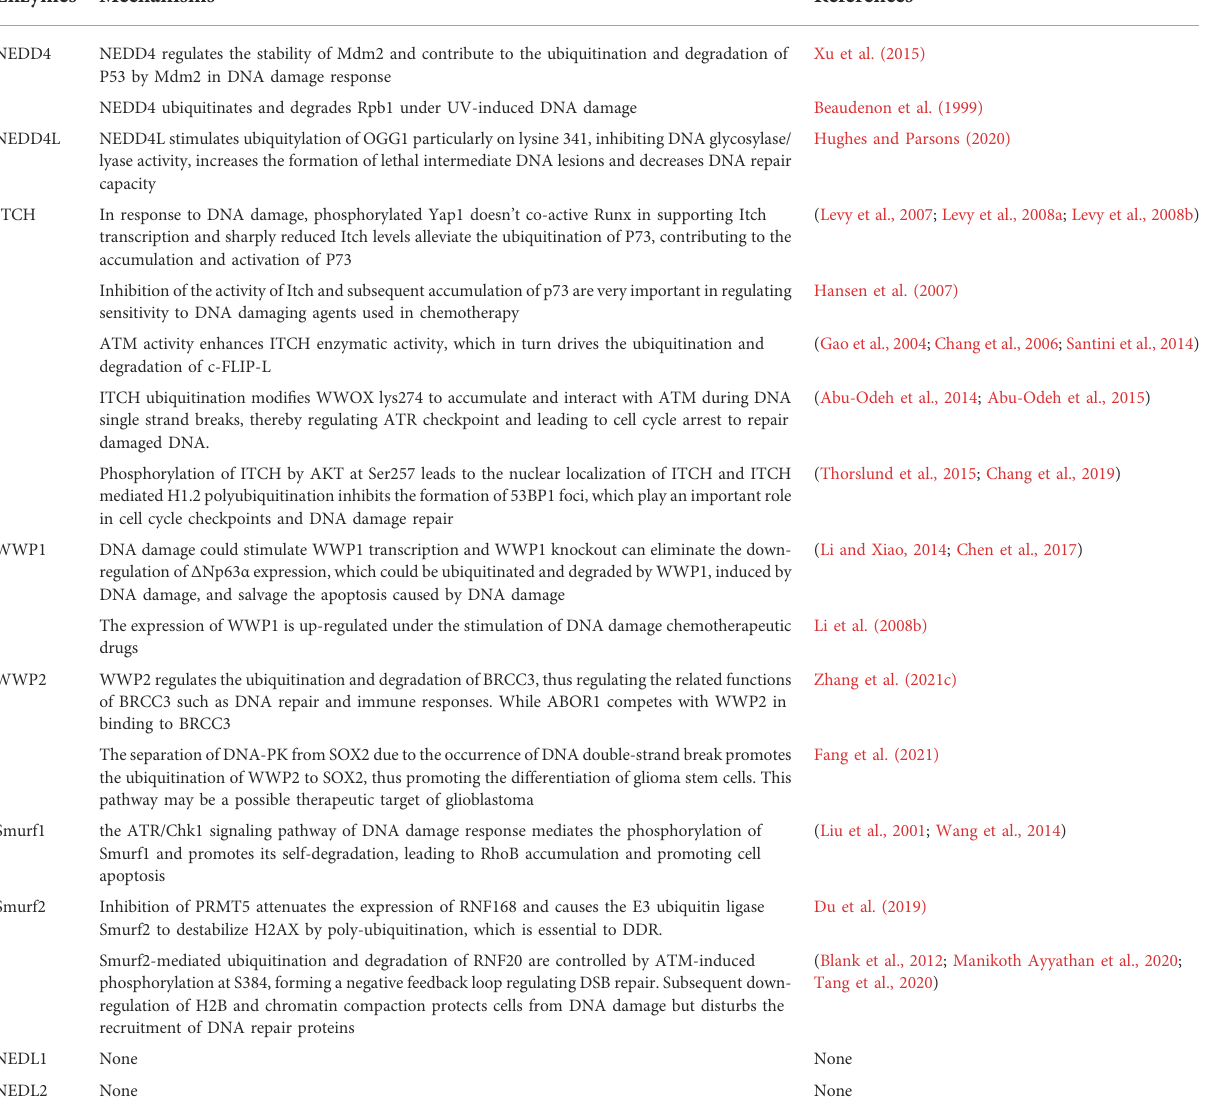
TABLE 1 The summary of E3 ubiquitin ligase NEDD4 family regulatory roles in DDR. Enzymes